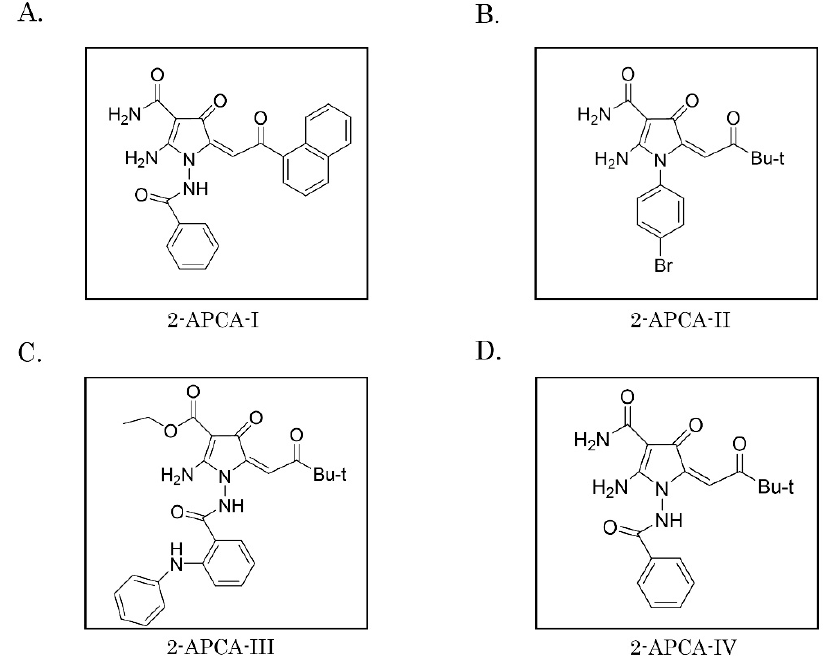
Figure 1. The chemical structures of 2-APCAs are displayed. ( A ) 2-APCA-I; ( B ) 2-APCA-II; ( C ) 2- APCA-III; ( D ) 2-APCA-IV.